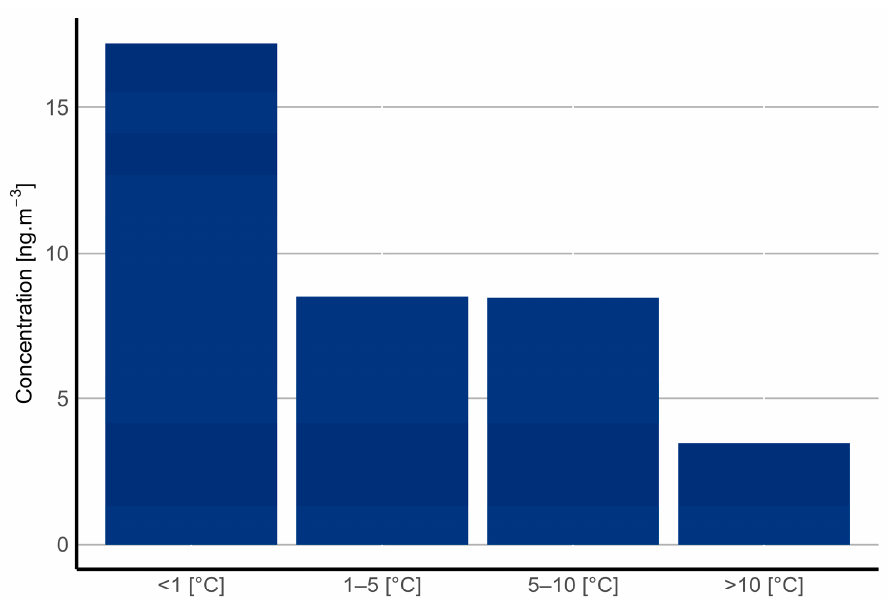
Figure 17. Average BaP concentrations by air temperature categories, V ěřň ovice station, 2020.